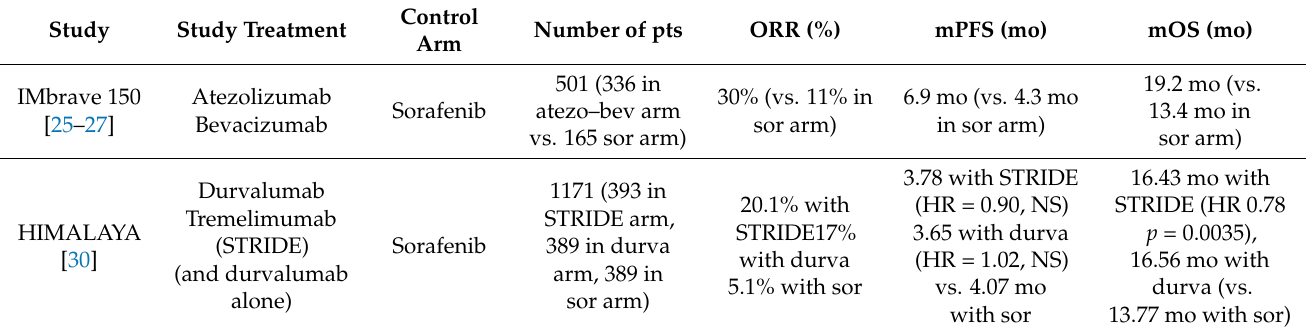
Table 1. Two new standards of care for advanced HCC systemic treatment: ICI-based